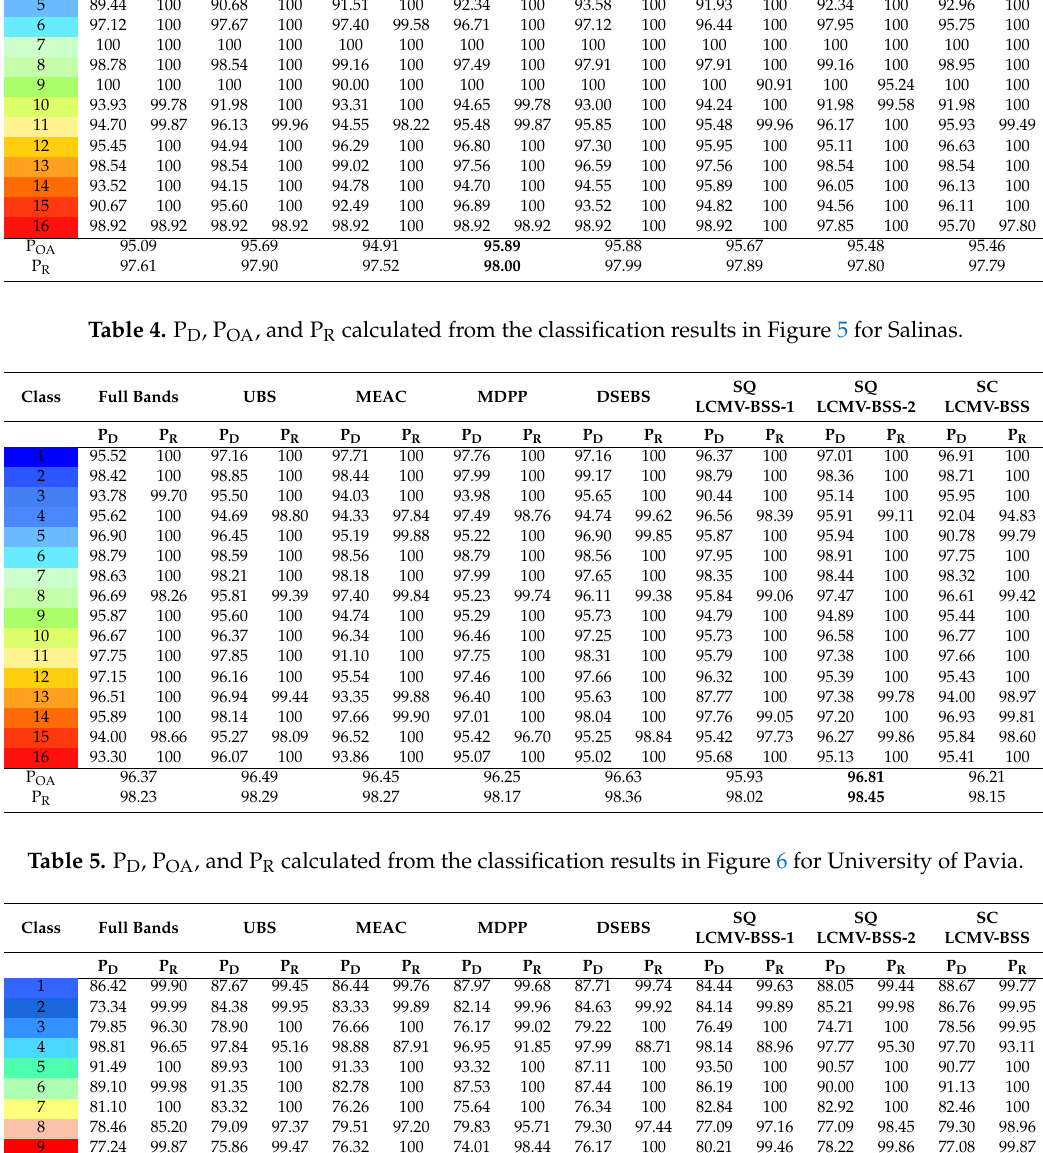
Table 6 tabulates the computing times in seconds for each of six BS methods in a computer environment with a 1.6 GHz Intel Core i5 with OS X EI Capitan and 4 GB 1600 MHz DDR3; the software used to run experiments was Matlab_R2014b. Obviously, the best time was achieved by DSEBS, followed by SC LCMV-BSS and SQ LCMV-BSS. The worst time was achieved by MDPP for the Purdue data and MEAC for Salinas and University of